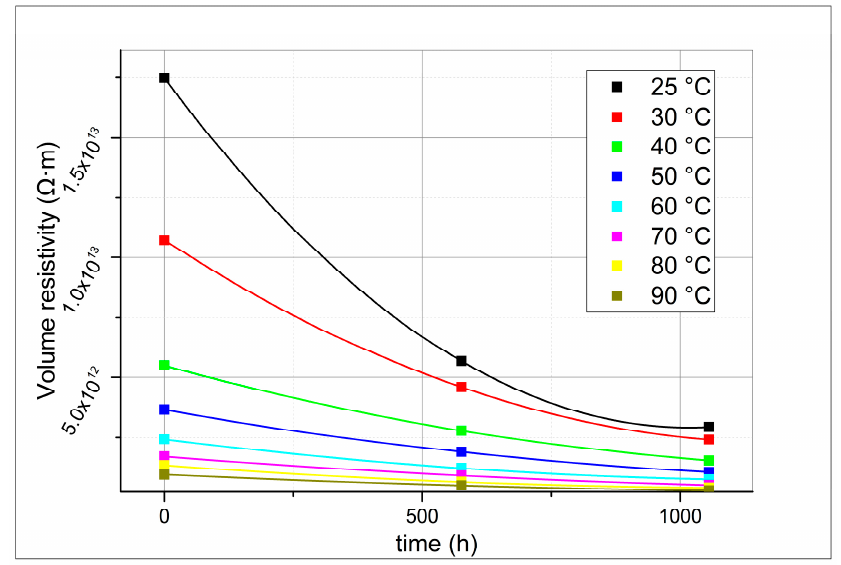
Figure 5. Time dependency of the resistivity of rapeseed oil at 140 °C exposure.